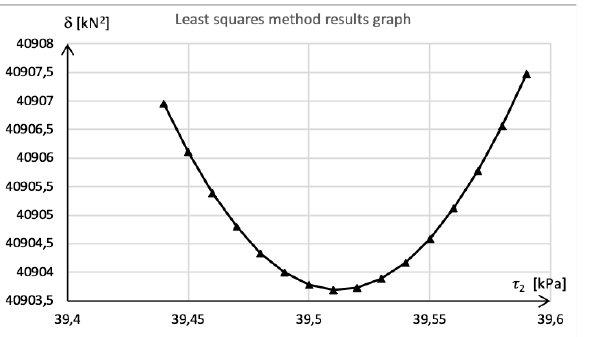
Figure 8a: Relationship between settlement and shear stress at the =2400 kN. head of Pile 2. 2